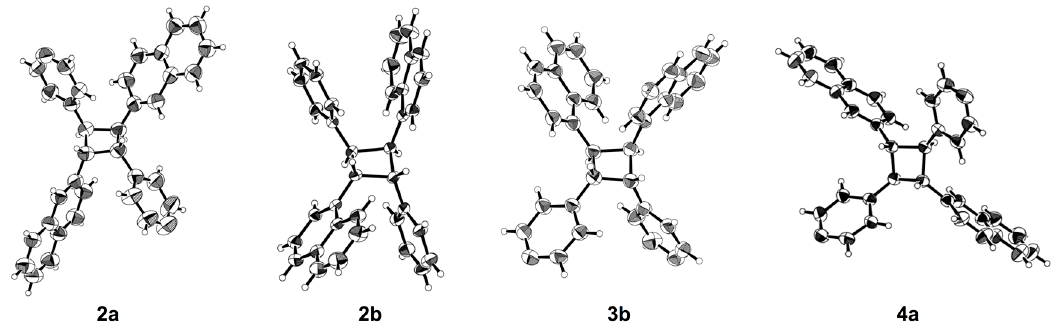
Figure 4. X-ray structures of 2a , 2b · 2HCl, 3b , and 4a .